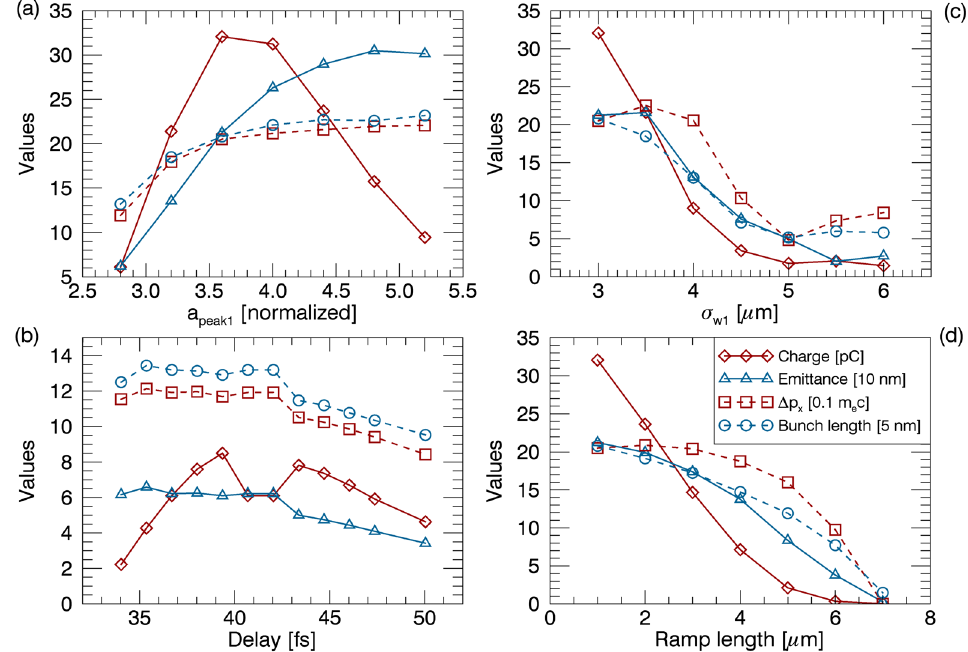
FIG. 2. Injected charge, rms emittance, rms momentum spread and rms bunch length for different simulation parameters, (a) peak injector amplitude a , (b) time delay t , (c) focal spot size σ , (d) ramp length. These statistics are obtained by taking all electrons w 1 peak 1 delay above 7.5 MeV into account at simulation time t ≈ 667 fs. The charge is estimated by assuming the width of the simulation box in the z direction is the same as that in y .